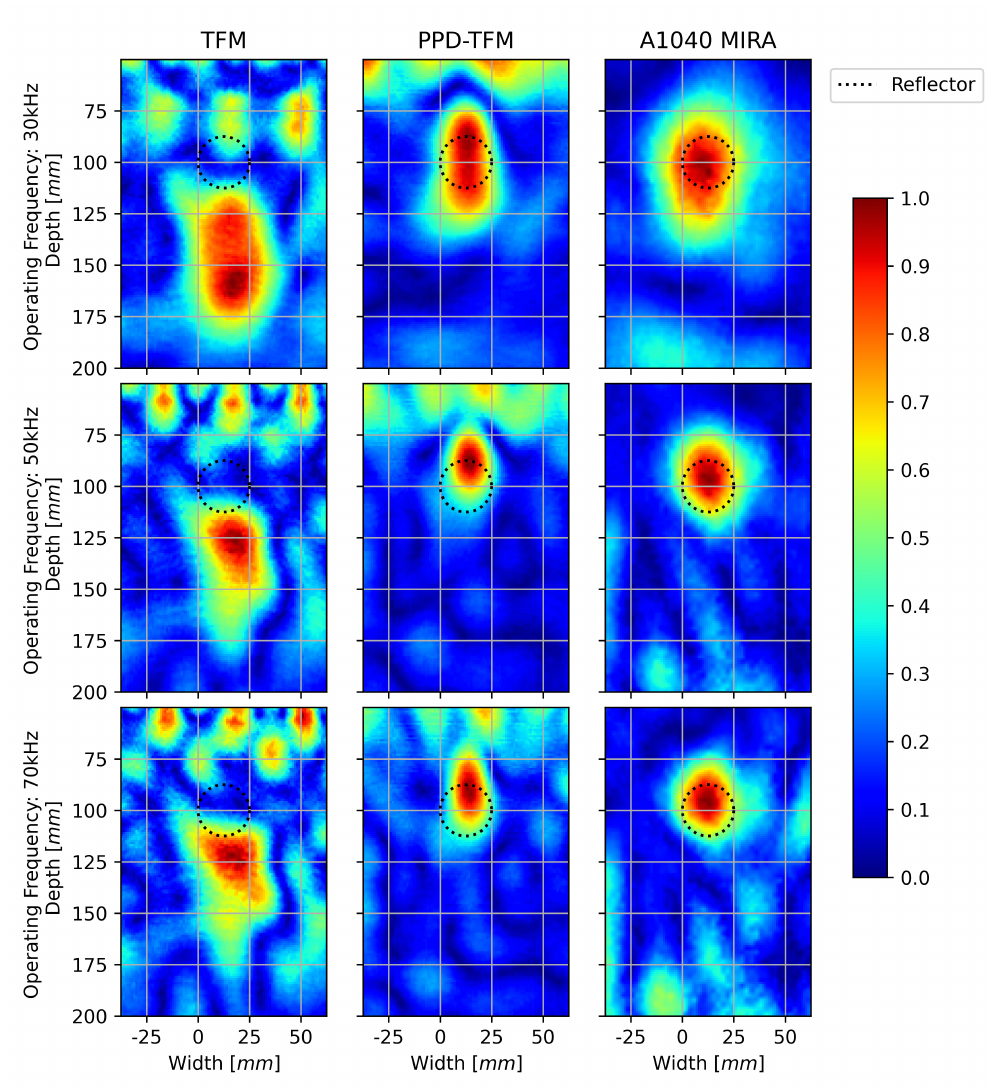
Figure 8. B-scan for concrete cube specimen by TFM ( left ), PPD-TFM ( center ), and SAFT-C ( right